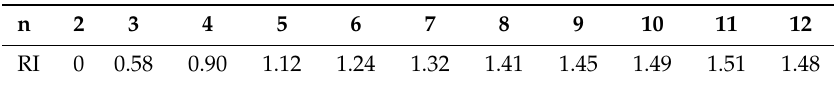
Table 5. Random Index table [51].